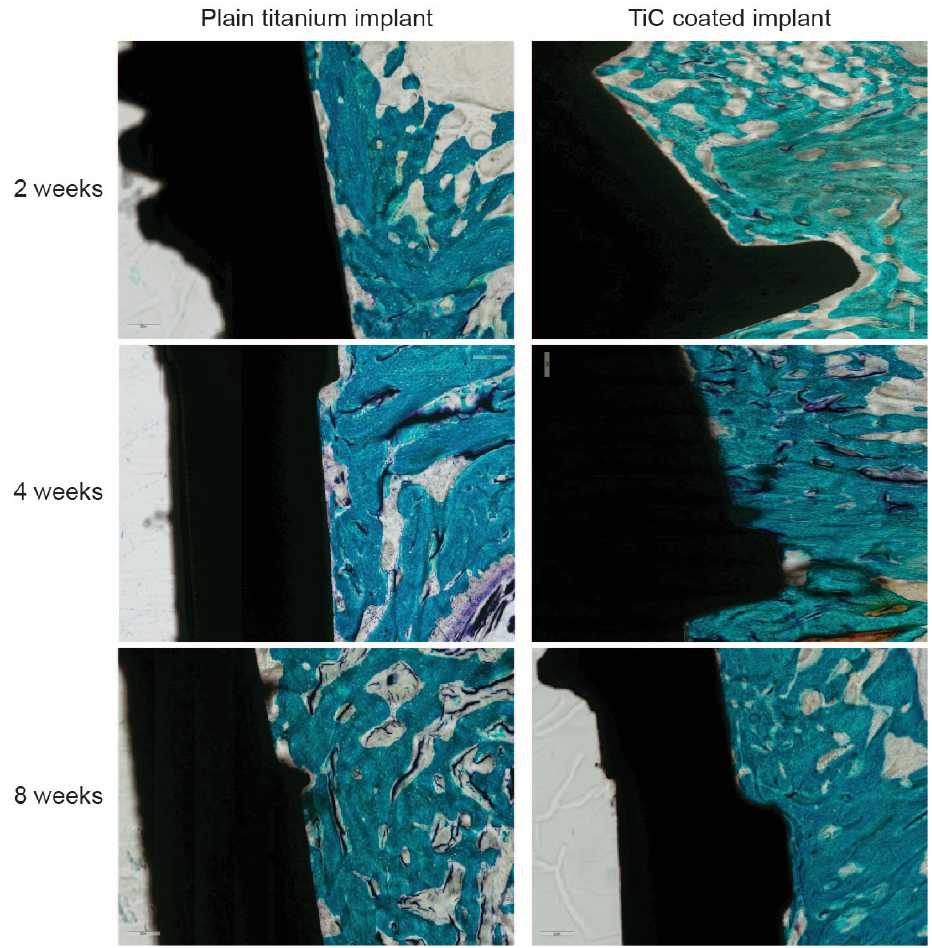
Figure 9. Histological images of the in vivo study of uncoated (Ti) and TiC-coated (TiC) titanium implants at 2, 4 and 8 weeks: 10× of magnification, scale bar is 200 µm. Toluidine blue and fast green staining. Reprinted from [91] . Copyright (2017), with permission from Elsevier.